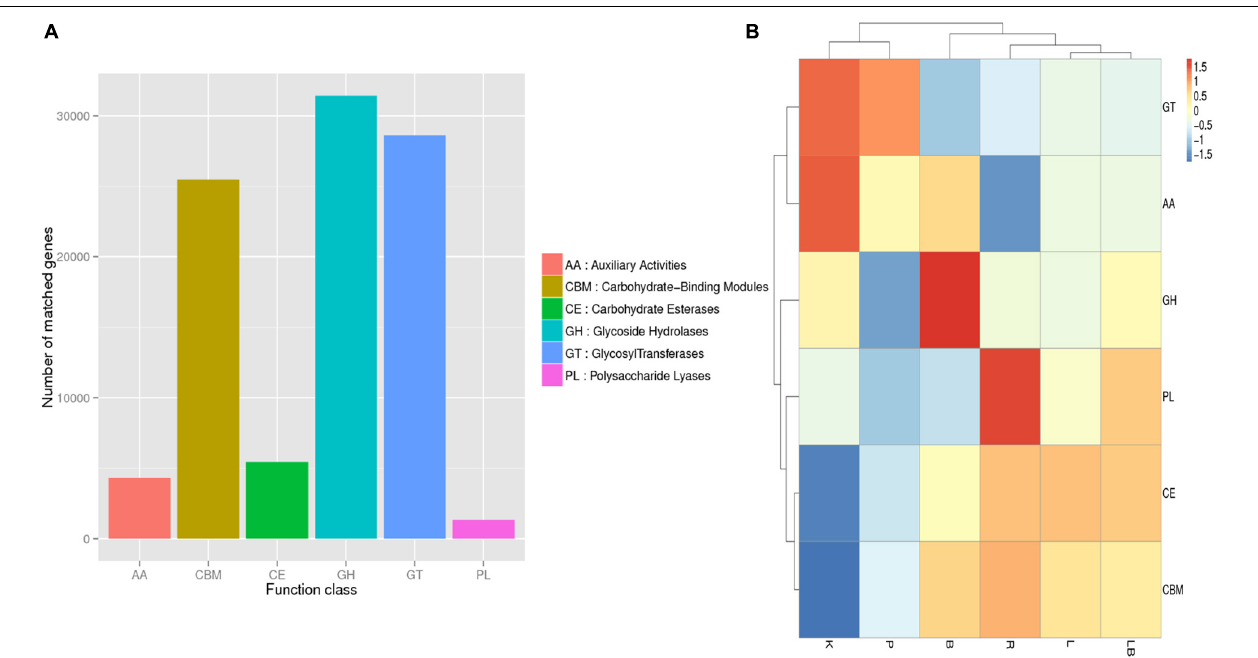
FIGURE 5 | Carbohydrate-Active Enzymes Database (CAZy) annotation analysis of freshwater benthic freshwater biofilm samples. (A) Numbers of genes annotated to the CAZy database in the combined column- and organic isolation-based groups. (B) Functional annotation analysis of the relative abundances in the six extraction groups, based on CAZy database level 1 including six major function classes. Abbreviations of extraction groups denote, K: Column-based kit isolation; R: RNAzol only group; B: Bead-beating group; L: Lysozyme group; P: Cell disruption bomb; LB: Lysozyme + Bead-beating